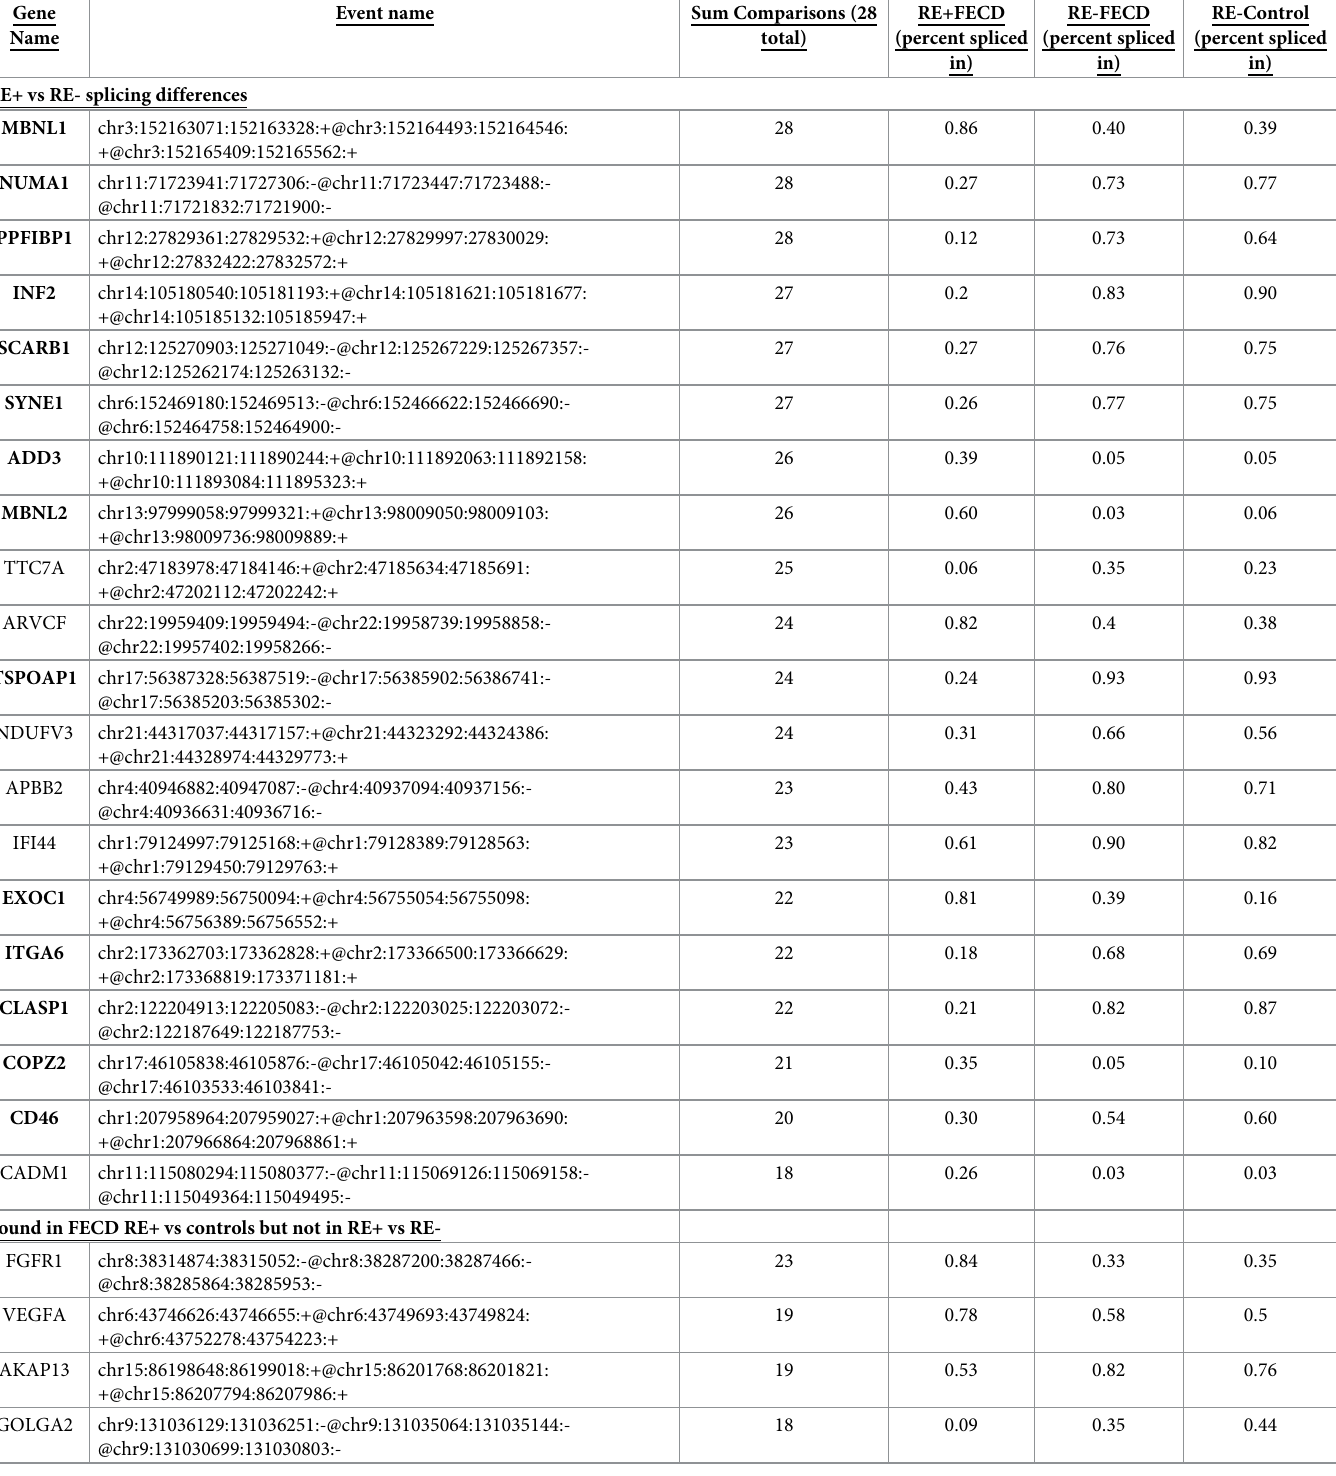
Table 3. Differential splicing